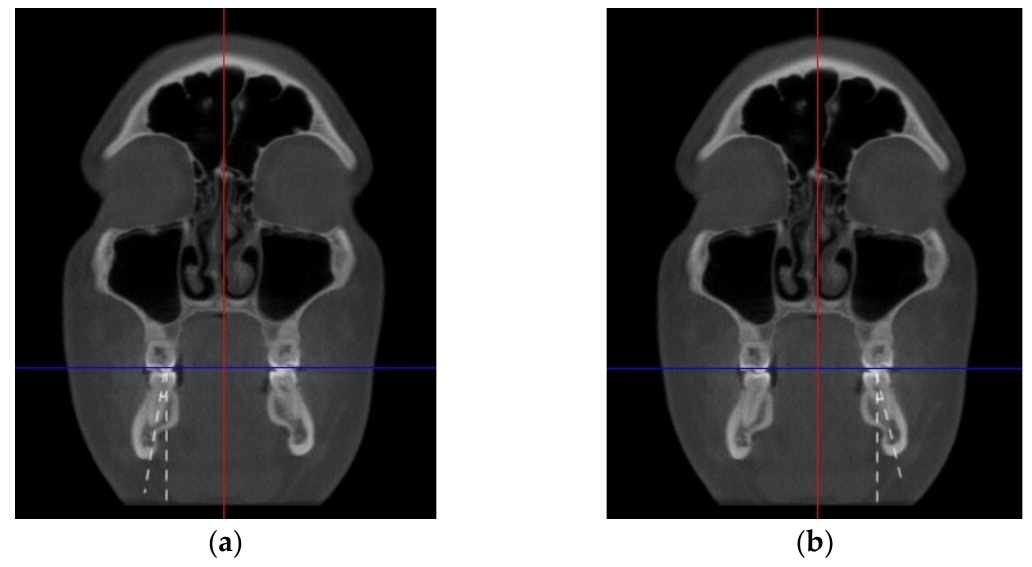
Figure 1. Measurement of mandibular right ( a ) and left ( b ) first molar inclination. The angle between line connecting the midpoint of the buccal and lingual cusp tips and the midpoint of the buccolingual width at the cementoenamel junction and vertical line was measured.